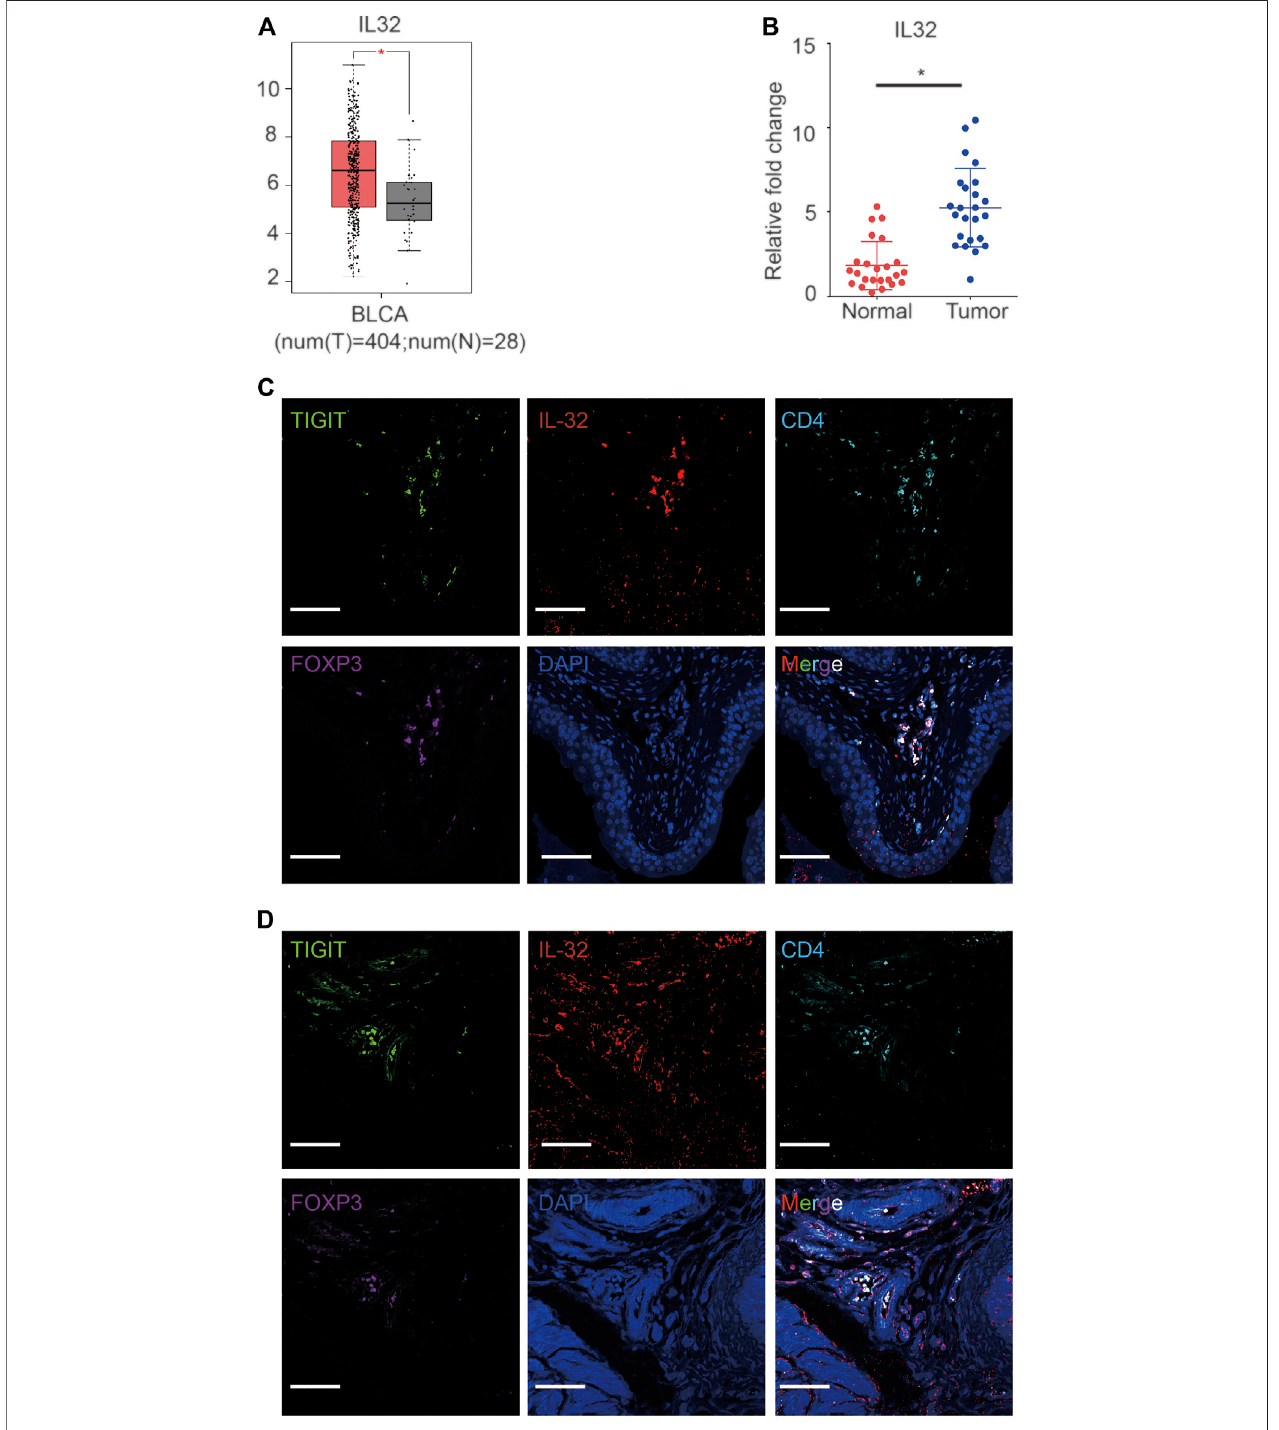
FIGURE 2 | Expression of IL-32 in Treg cells in bladder cancer tissues. (A) Higher expression of IL-32 in the bladder cancer cohort in the TCGA and GTEx databases. Dataare shown asthemean ± standard deviation (SD). * p < 0.05; t -test. (B) Higher relative expression ofIL-32 in bladder cancer tissues. qRT-PCR analysis showing the relative expression of IL-32 in healthy and cancerous bladder tissues. Data are shown as the mean ± SD. * p < 0.05; t -test. (C) IL-32 colocalizes with Treg cells in human bladder cancer tissues. Representative immuno fl uorescence images showing cells stained with anti-FOXP3 (violet), IL-32 (red), CD4 (light blue), TIGIT (green), and DAPI (blue). Scale bar (cid:1) 100 μ m. (D) IL-32 colocalizes with Treg cells in murine bladder cancer tissues. Representative immuno fl uorescence images showing cells stained with anti-FOXP3 (violet), IL-32 (red), CD4 (light blue), TIGIT (green), and DAPI (blue). Scale bar (cid:1) 100 μ m.